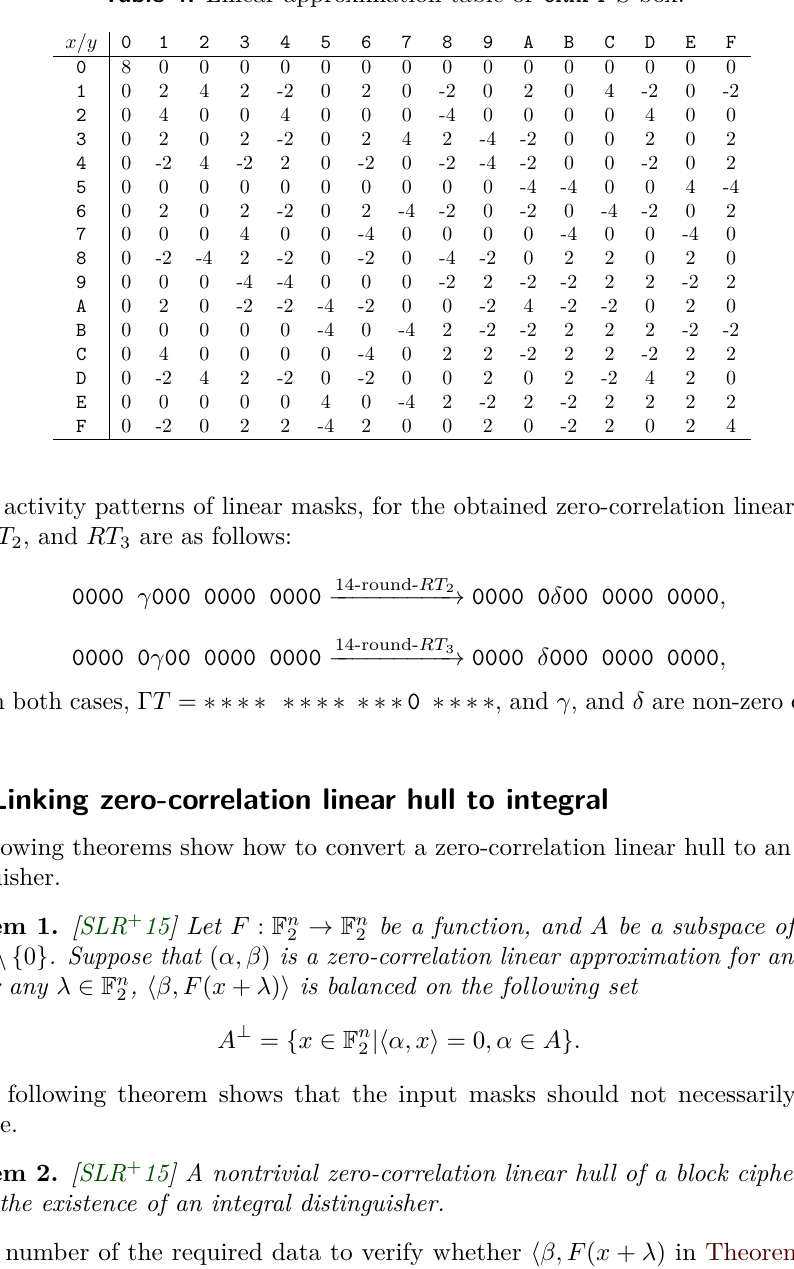
Table 4: Linear approximation table of CRAFT